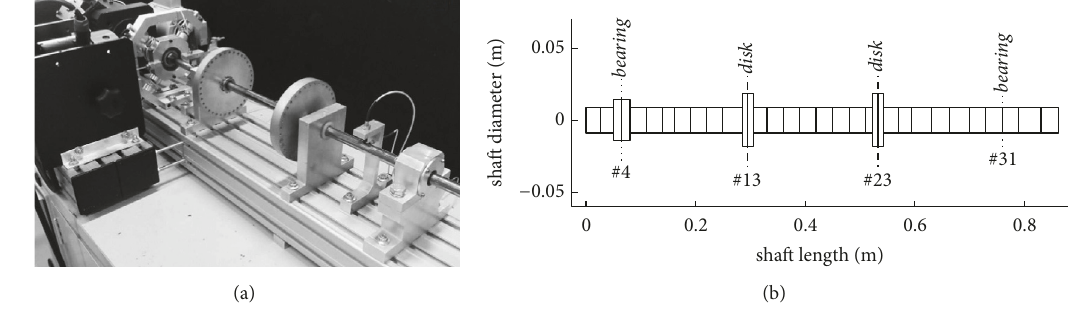
Figure 1: Rotating system: (a) test rig (real system); (b) FE model [14].